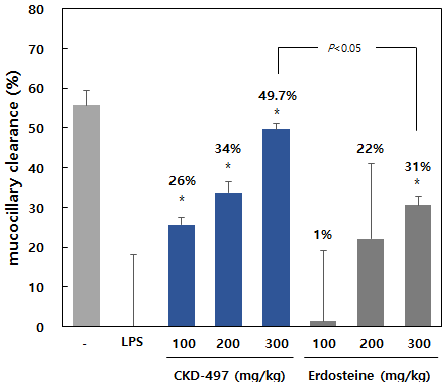
Figure 6. CKD-497increasedmucociliaryclearanceinrats. Aftereuthanasia, ratswereinducedrespiratory infection by LPS. After 3 h, CKD-497 or positive control was orally administrated and then 5% carbon solution was injected in bronchoalveolar lavage (BAL). We measured the optical density of the liquid extracted from BAL. Data are expressed as the mean ± SEM ( n = 3–5). * p < 0.01 compared with